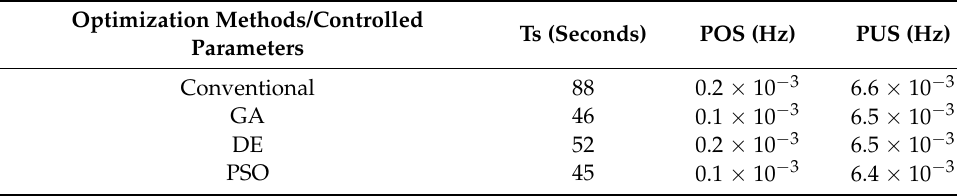
Table 4. Controlled parameters of delF using the ISE cost